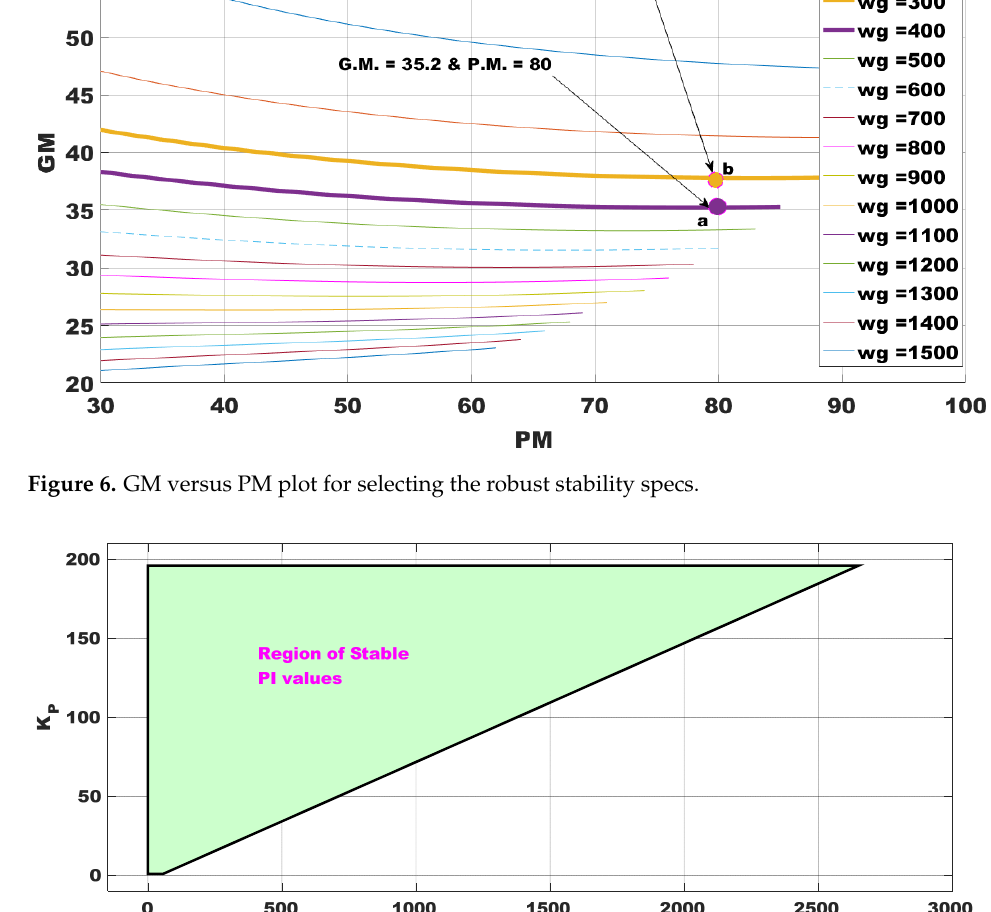
Figure 6. GM versus PM plot for selecting the robust stability specs.